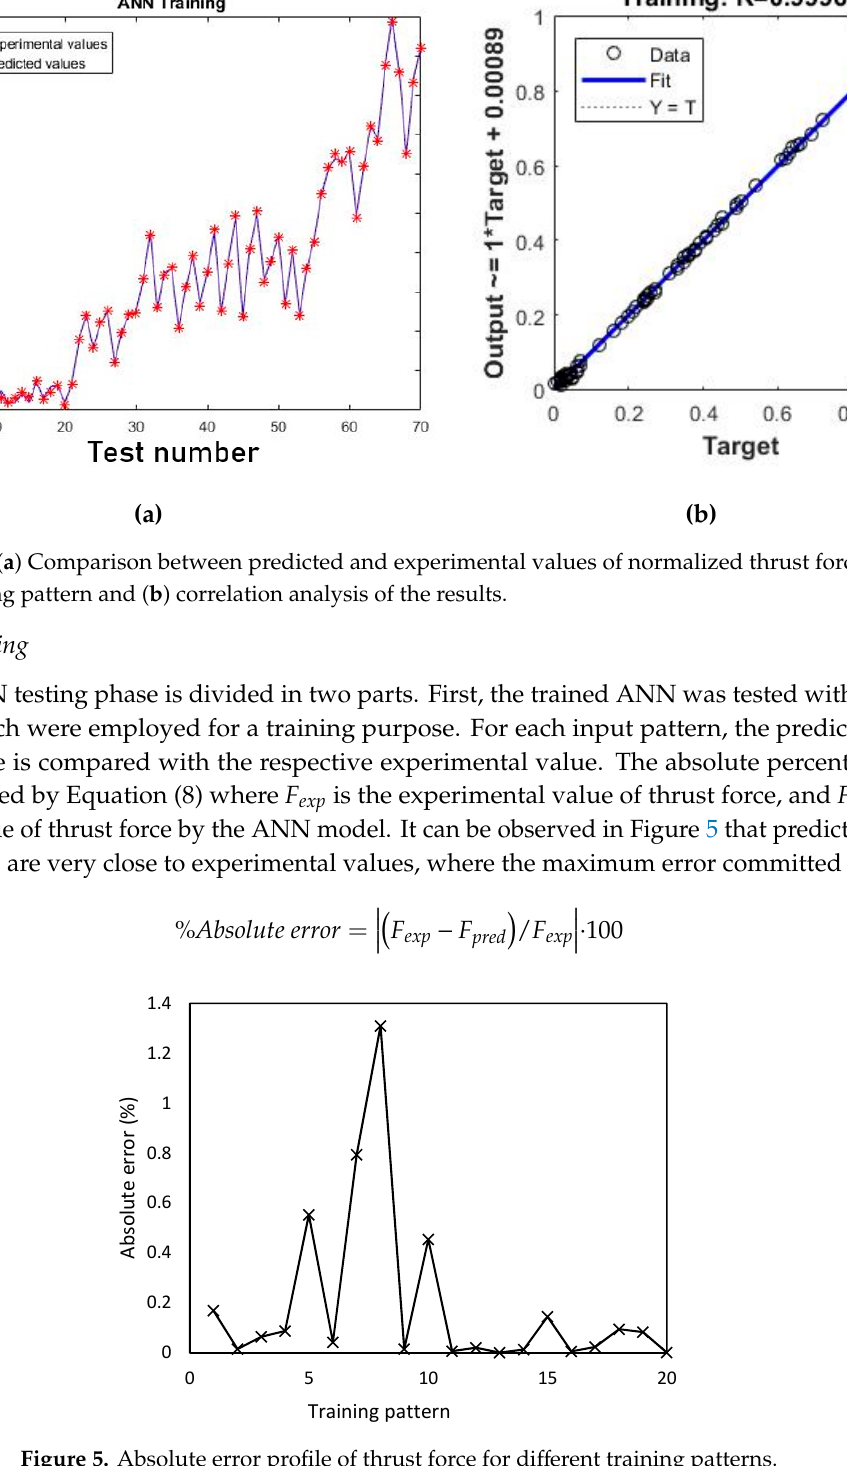
Figure 5. Absolute error profile of thrust force for different training patterns.